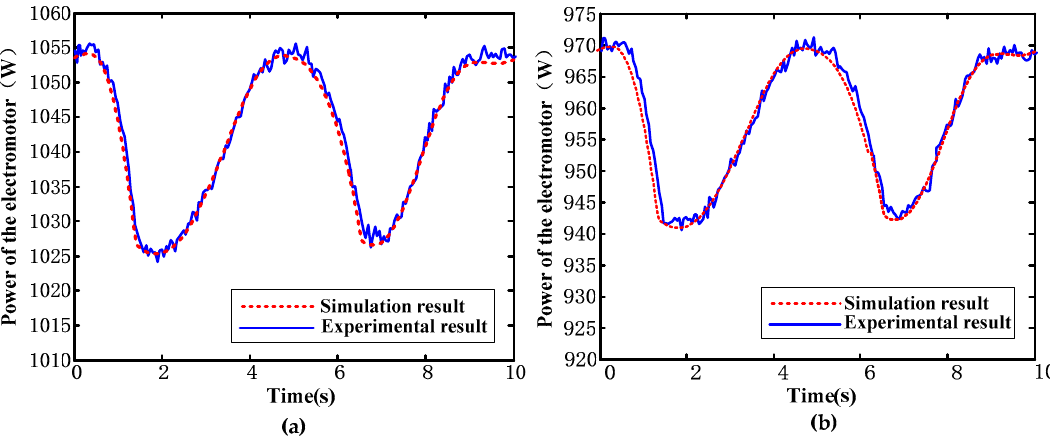
Figure15. The output power experiment contrast curves of the electromotor under different coupling speeds. ( a ) Coupling speed of 730 r/min; ( b ) coupling speed of 460 r/min.